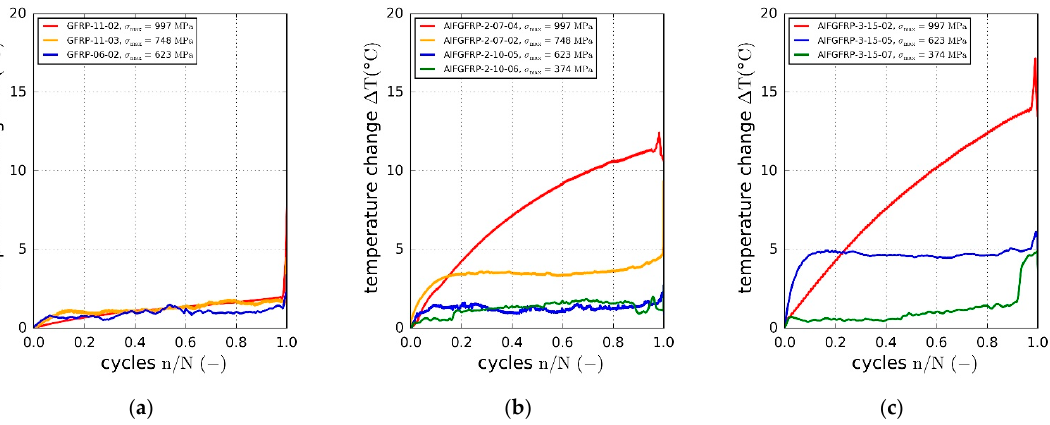
Figure 16. Surface temperature change against the normalized fatigue life: ( a ) reference laminate; ( b ) laminate with work-hardened aluminum fibers; ( c ) laminate with soft-annealed aluminum fibers.